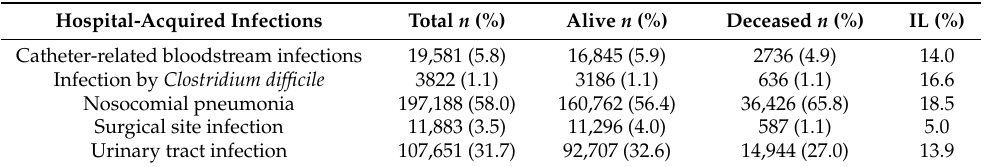
Table 3. Frequency of HAI hospitalizations by context, outcome (alive or deceased during the hospital stay), and in-hospital lethality rate (IL).